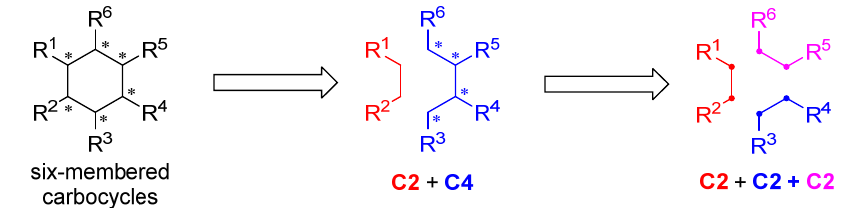
Table 1. Screening studies for the [2+2+2] annulation to synthesize six ‐ membered carbocycles a